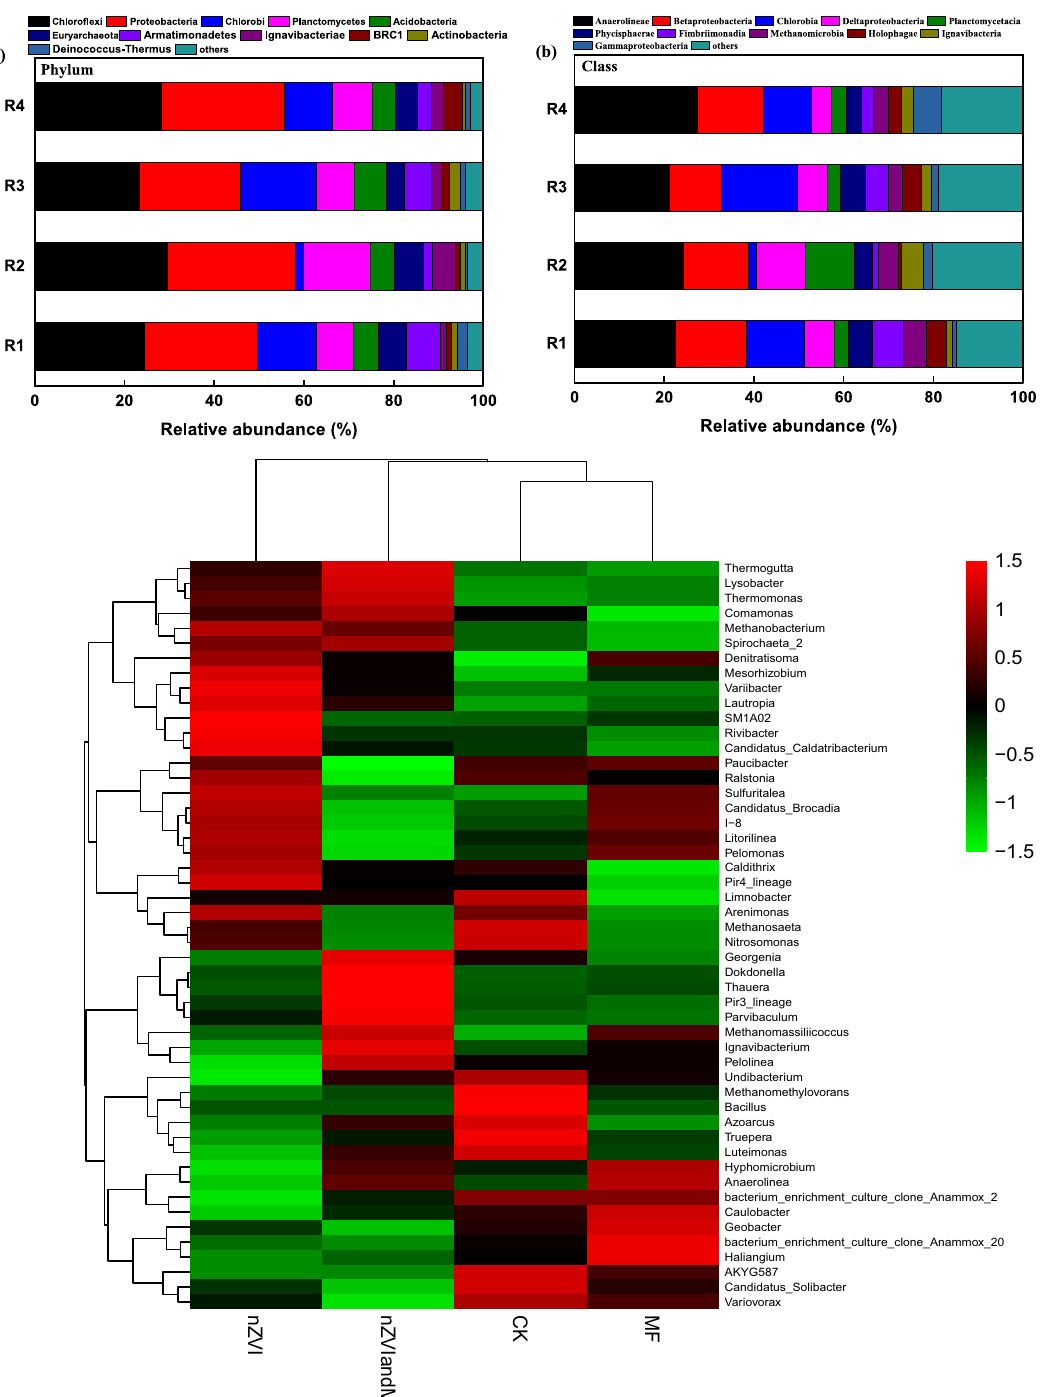
Fig. 5 The microbial community structure of sludge samples. a Top 12 abundant phyla at the phylum level, b top 11 abundant classes at class level, and c heat map of top 50 genera at the genus